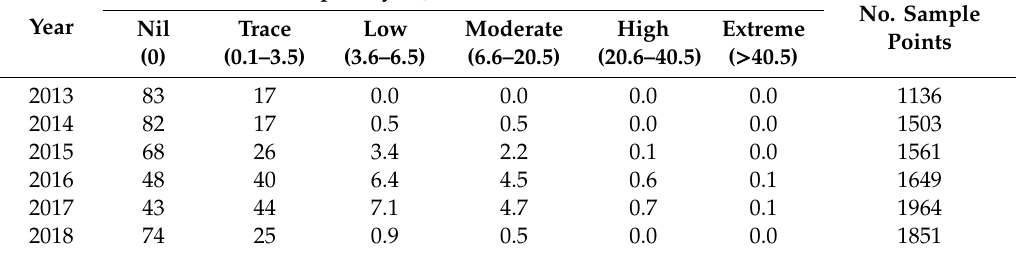
Table 1. Percentage of SBW L2 samples in New Brunswick in six second instar larvae (L2) classes, each year from 2013–2018. Three mid-crown branches were sampled at each sample point each year. Locations of sample points are shown in Figure